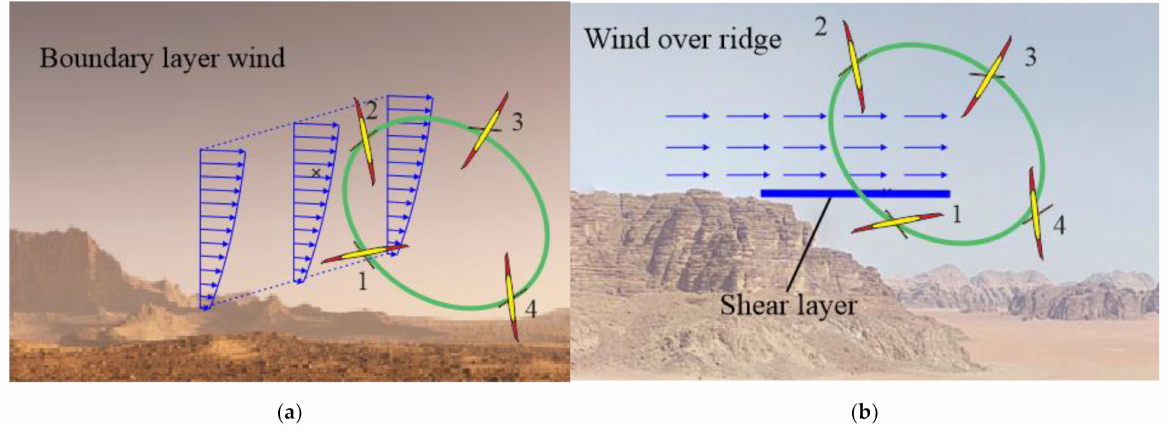
Figure 5. Dynamic soaring: ( a ) in atmospheric boundary layer (1—windward climb, 2—high- altitude turn, 3—leeward descent, and 4—low altitude turns); ( b ) in a shear layer developed over leeward